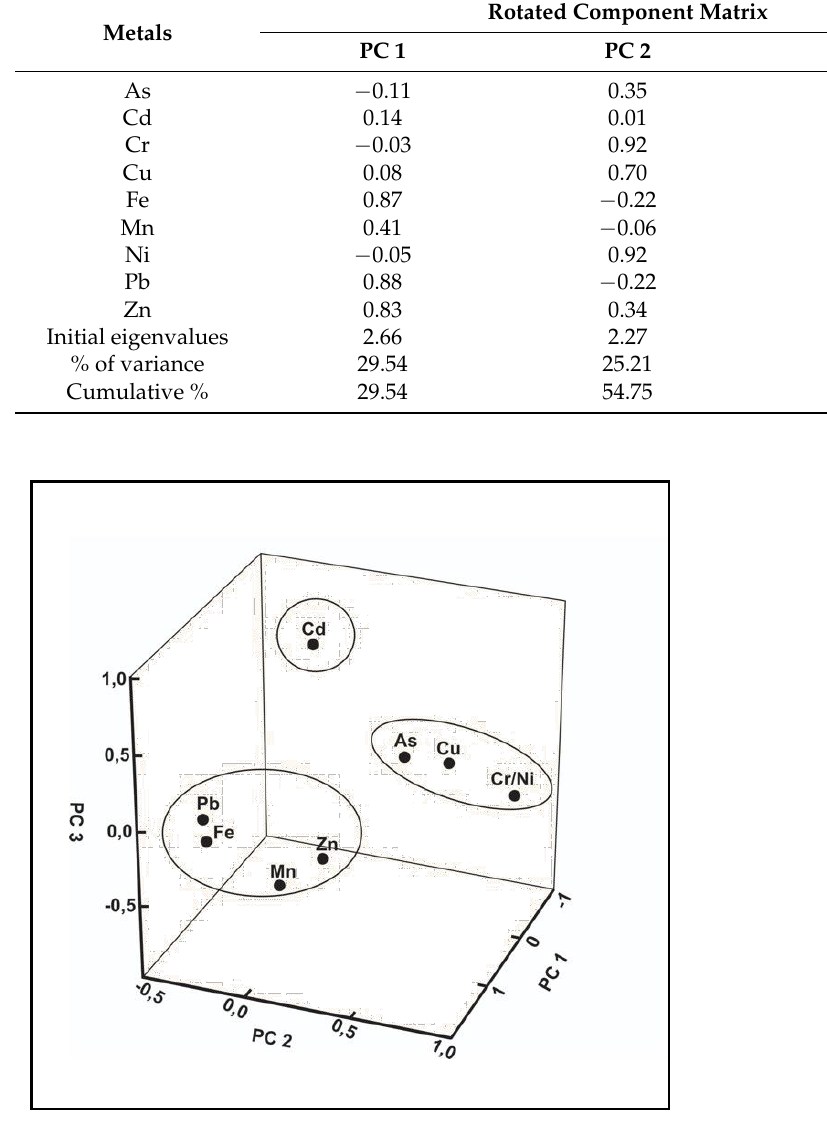
Figure 10. PCA analysis